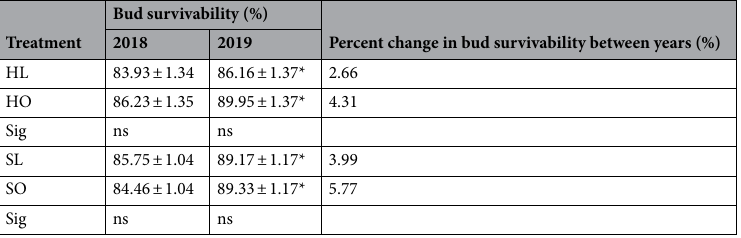
Table 1. Effect of lateral removal on the bud survivability of ‘Riesling’. Significant differences between years ( p < 0.05) are designated by *.